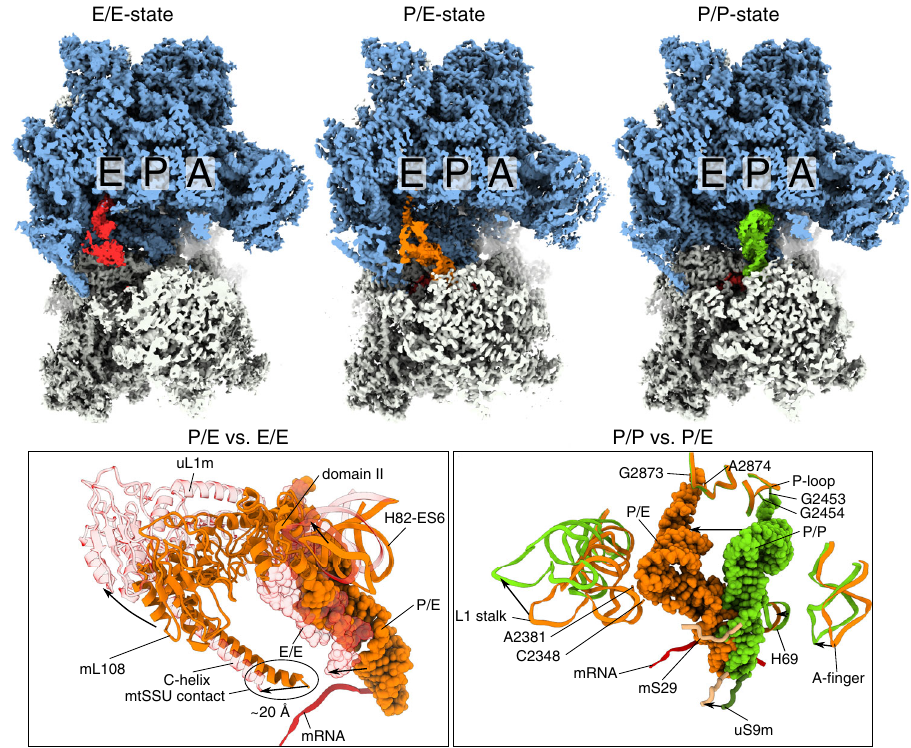
Fig. 3 Translocation of tRNA and the L1 stalk. 3D reconstructions of the different states are shown for the E/E tRNA state for the P/E tRNA state and for the P/P tRNA state (mtLSU blue; mtSSU gray). Structural rearrangements upon transition between the P/E and E/E states and € between the P/P and P/E state are shown. Each of the two states have been superimposed, and the affected structural elements are shown according to the text. Movements of the structural elements between the states are indicated by arrows and the contact site to mtSSU is